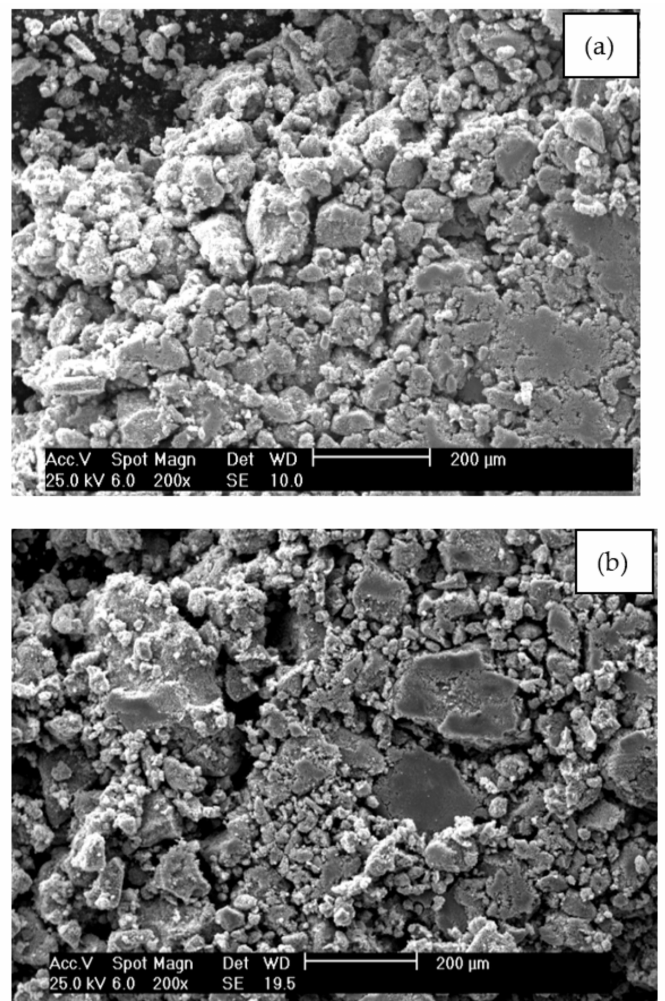
Figure 5. SEM results of ZnO ( a ) and 100 W-ZnO ( b )